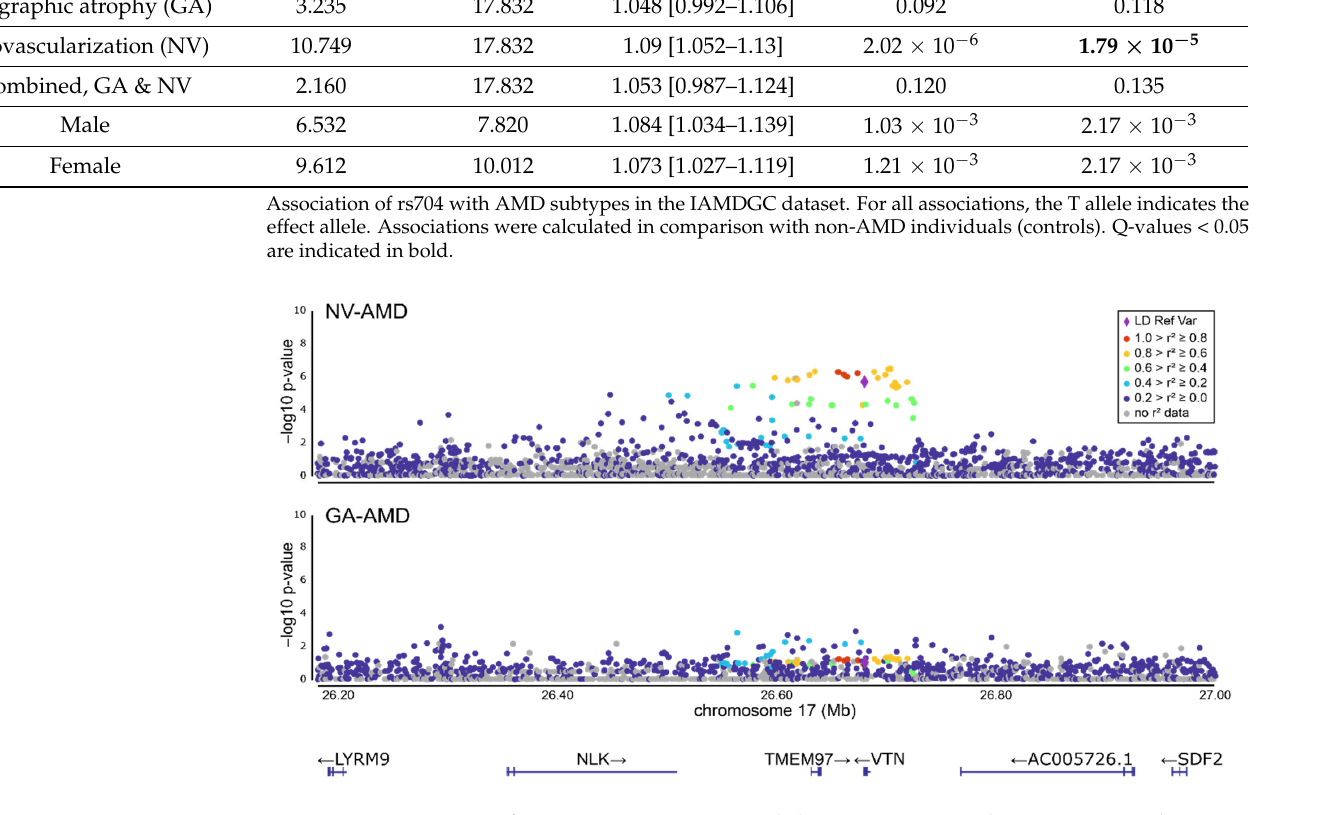
Figure 1. Association of genetic variant rs704 with late ‐ stage AMD subtypes neovascular AMD (NV ‐ AMD) and geographic atrophy (GA ‐ AMD). The association of rs704 with AMD was calculated sep ‐ arately for both late ‐ stage disease phenotypes in the IAMDGC dataset. While an association signal with AMD was detected in the NV subgroup, an association in GA samples is not evident. Variant rs704 is presented as purple diamond and serves as linkage disequilibrium (LD) reference variant. Transcript map with direction of transcription is given at the bottom. Plots were generated with Locuszoom [26,27].